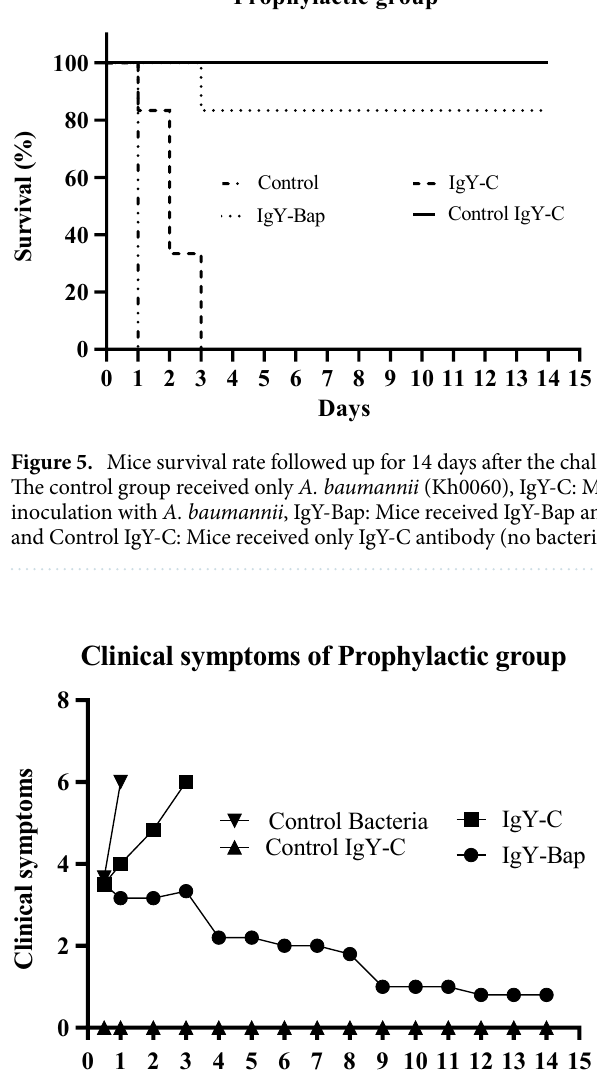
selected region is covering less than 5% of the Bap sequence. Expression level and the number of Bap expressed on A. baumannii are also involved in the observed absorbance of whole-cell ELISA. ELISA results showed no significant difference between titers of specific antibodies raised after the third and fourth injections. Three injections with 3-week intervals are sufficient to reach the highest titer of anti-Bap IgYs. Specific anti-Bap IgY